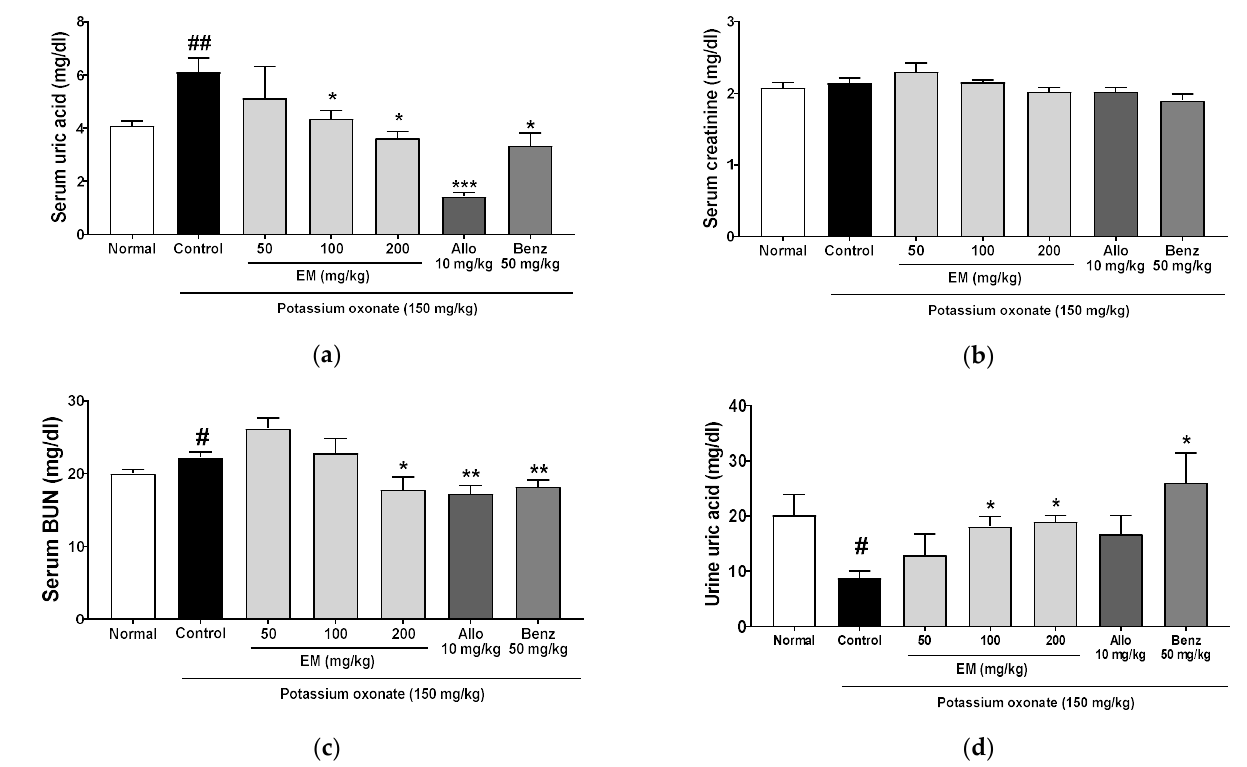
Figure 2. The effects of EM on the parameters of serum uric acid levels and kidney function in rats with potassium oxonate (PO)-induced hyperuricemia (5-day treatment duration). ( a ) Serum uric acid. ( b ) Serum creatinine. ( c ) Serum blood urea nitrogen (BUN). ( d ) Urine uric acid; (n = 5 per group). Allo, allopurinol; Benz, benzbromarone. # p < 0.05 and ## p < 0.01 vs. the normal group; * p < 0.05, ** p < 0.01 and *** p < 0.001 vs. the PO group.